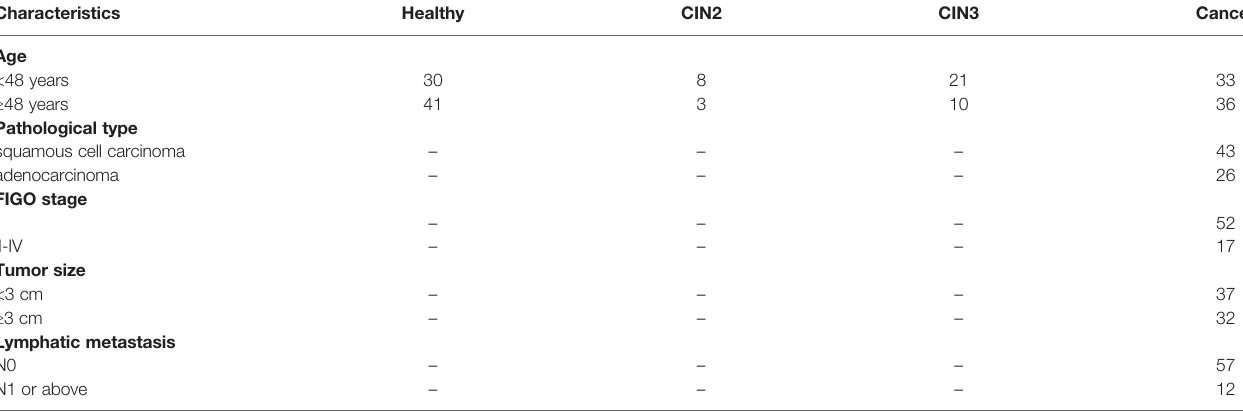
TABLE 1 | Clinicopathological features of patients included in this